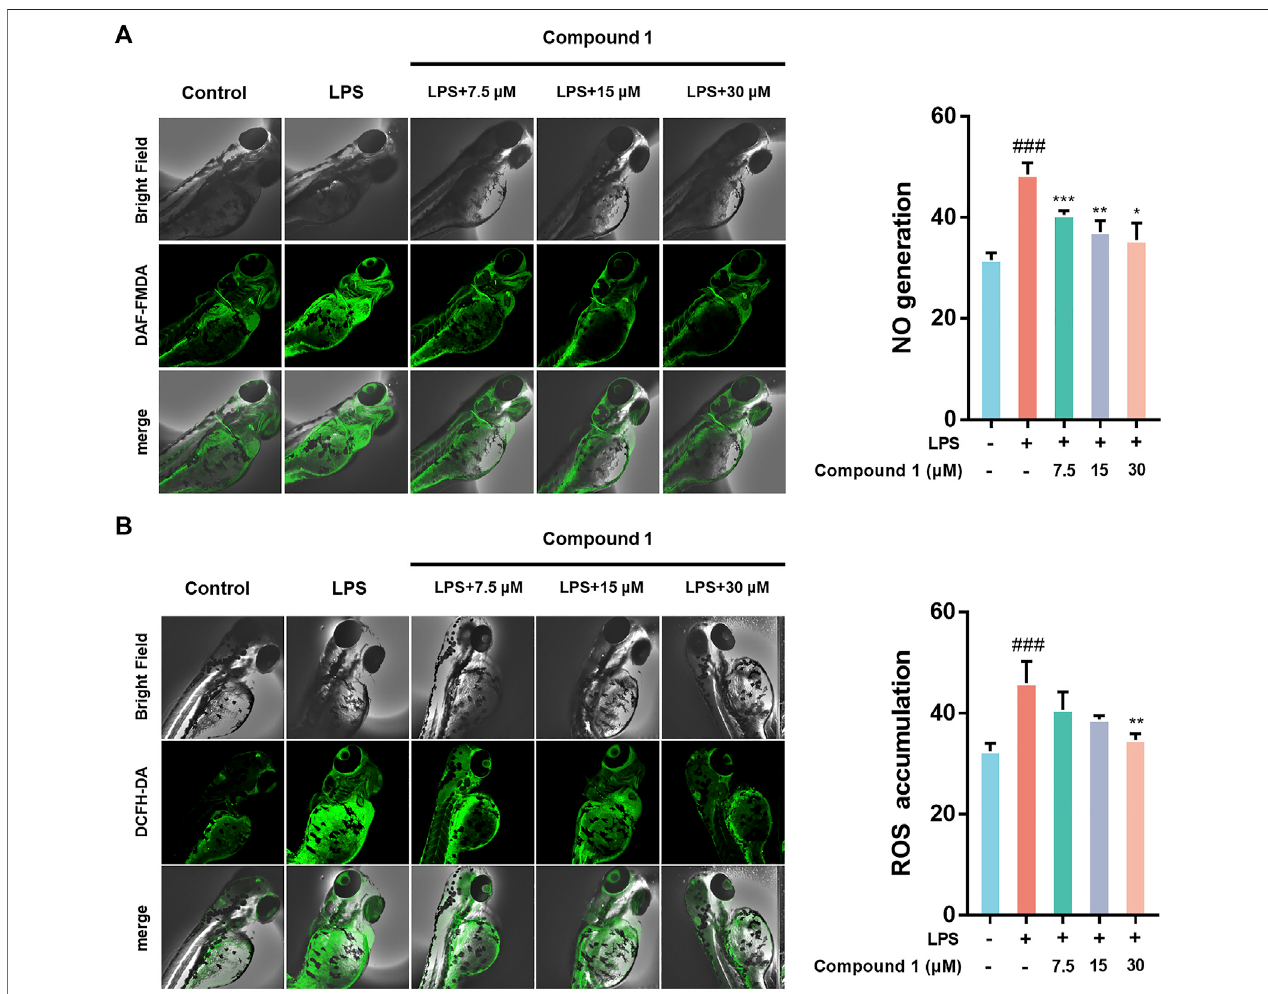
FIGURE 4 | (A) 1 inhibited the generation of NO in LPS-stimulated zebra fi sh. (B) 1 inhibited the accumulation of ROS in LPS-stimulated zebra fi sh. Zebra fi sh were stimulated with LPS (10 μ g/ml) and then treated with 1 or DMSO. Fluorescence intensity was quanti fi ed using ImageJ. Data are expressed as the mean ± SD. ### p < 0.001, compared with the normal control group. * p < 0.05, ** p < 0.01, and *** p < 0.001, compared with the LPS